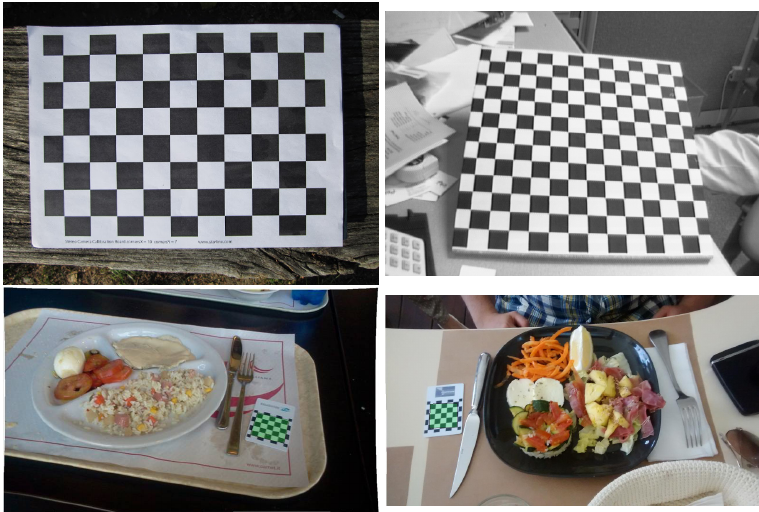
Figure 4. First row: typical images used for calibration. Second row: examples of images in which a checkerboard is used as size reference for food volume estimation, on which both OpenCV and Matlab functions for detecting checkerboards fail, while our model-based algorithm correctly locates them (green